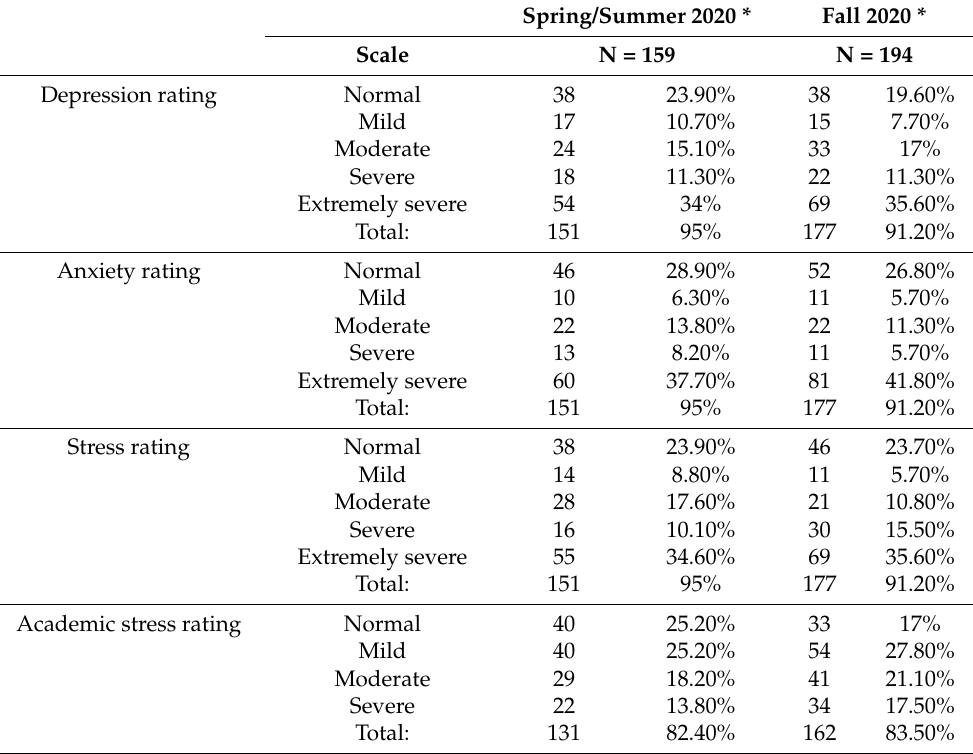
Table 2. Distribution of students in depression, anxiety, stress, and academic stress rating